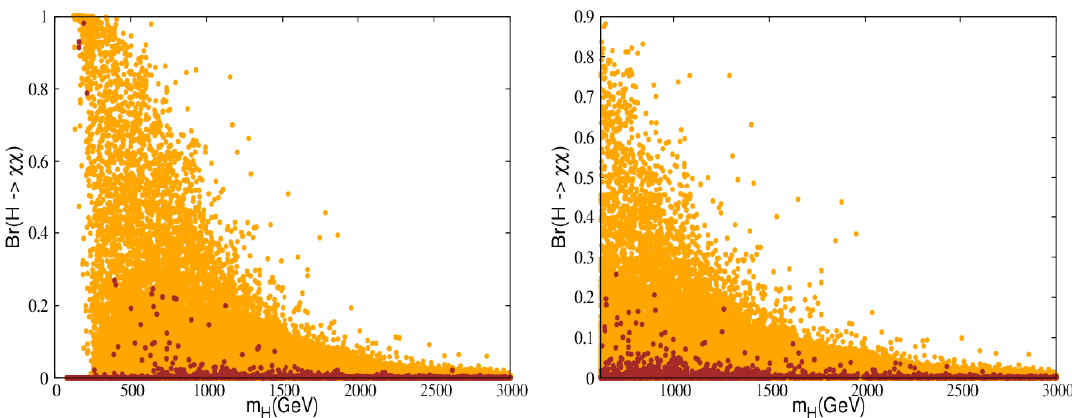
Figure 5 . Br( H χχ ) as a function of m H for Type I (left) and Type II (right) 2HDM. Color → code is same as in figure